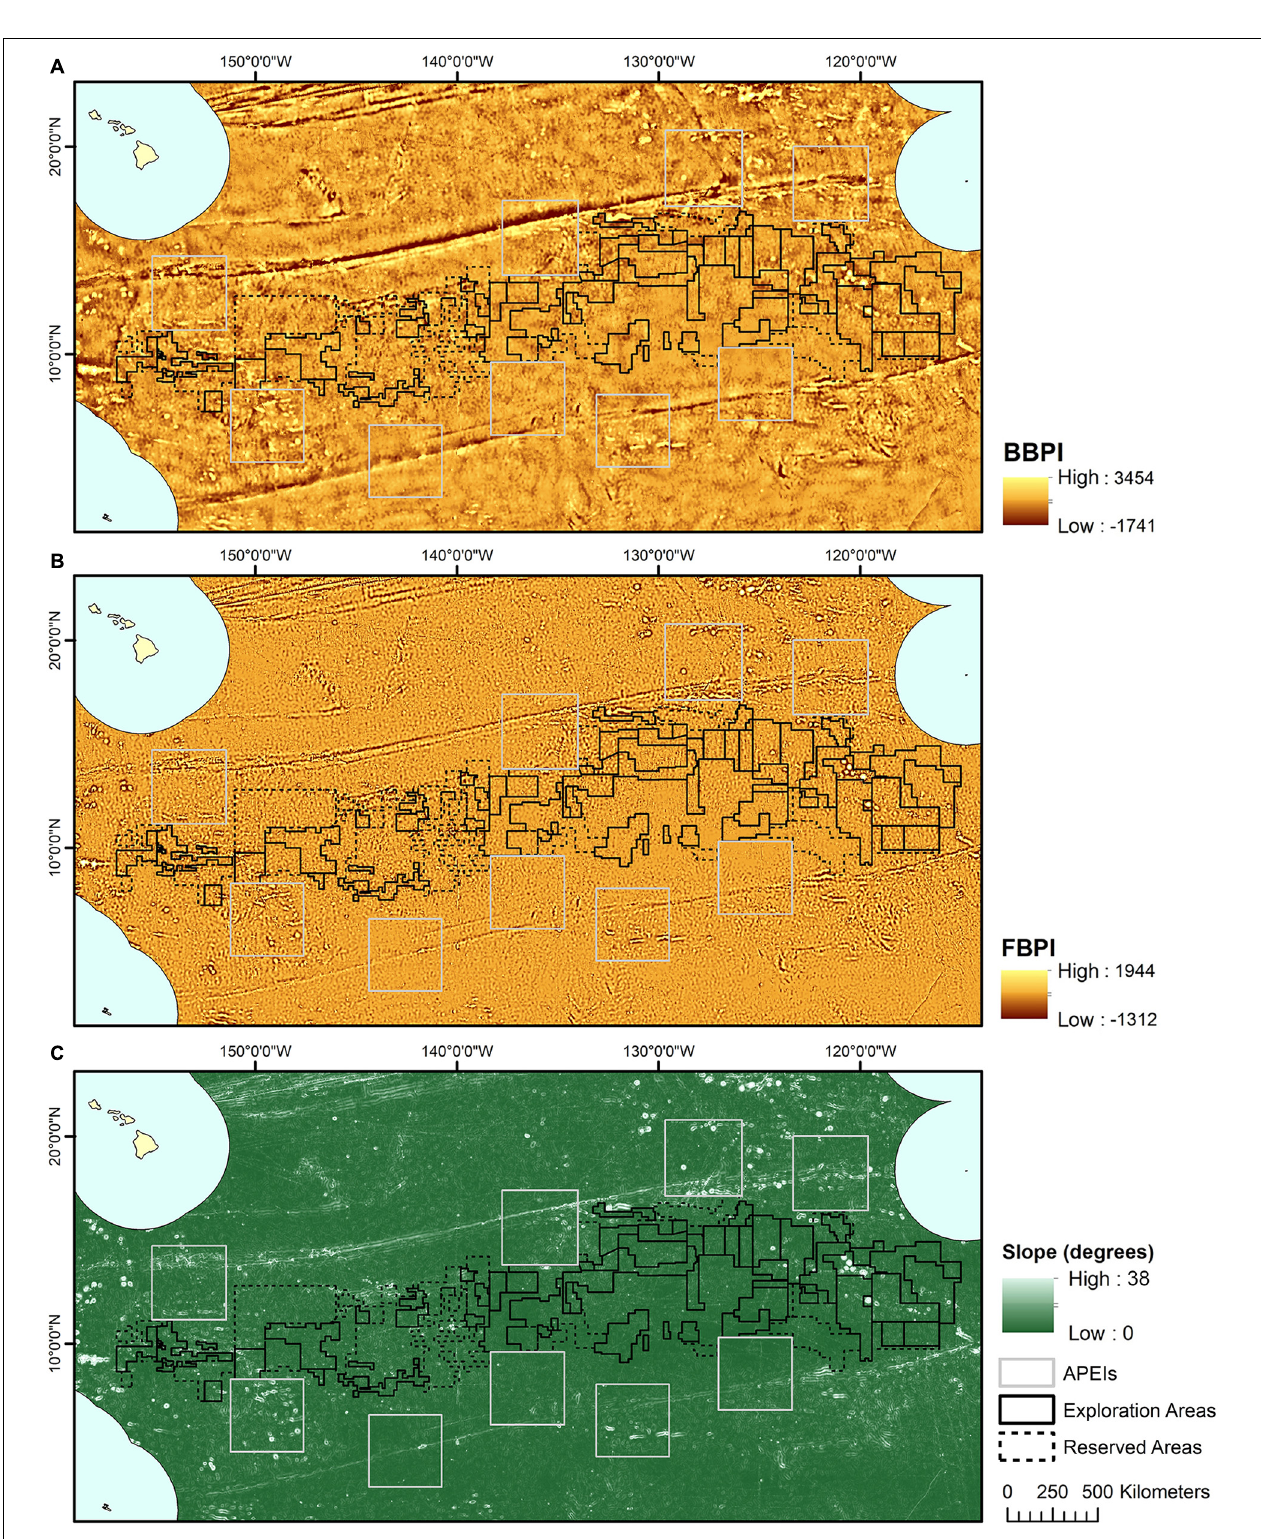
FIGURE 2 | Topographic variable layers used in initial clustering, (A) broad-scale bathymetric position index (BBPI), (B) fine-scale bathymetric position index (FBPI), and (C) slope, derived from GEBCO 2014 bathymetry data and interpolated to 1 km 2 resolution. Land masses are shown in cream as labeled in Figure 1 , surrounded by EEZs in pale